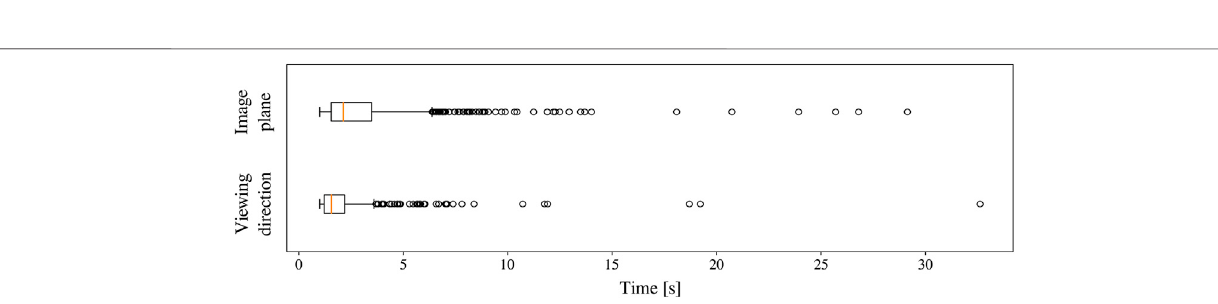
FIGURE 14 | Completion time for all the participants in the bi-manual coordination task. (A) Completion time across attempts, with novices (top), plateau novices (centre), and surgeons (bottom). (B) Completion time per group across all trials.